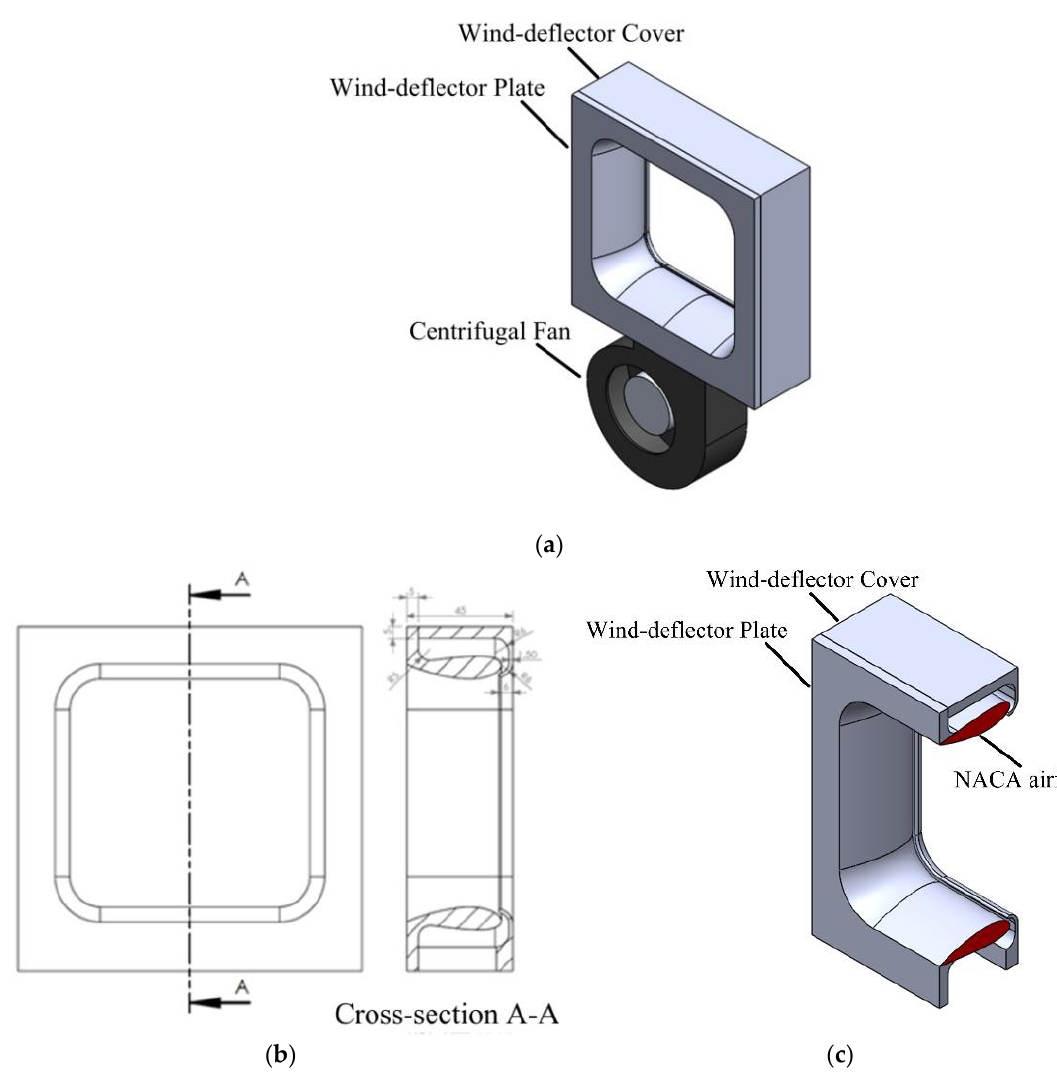
Figure 4. ( a ) Illustration of the window-type convection device, which comprises an airflow multiplier and centrifugal fan; when the centrifugal fan rotates, the airflow multiplier draws air from outside to create an airflow in its runner. ( b ) Front view and right-side sectional view of the airflow multiplier. ( c ) Position of the NACA airfoil in the wind-deflector plate.